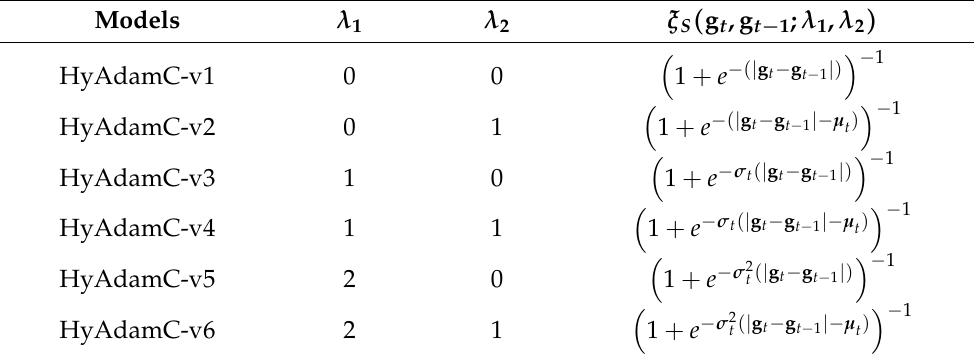
Table 2. The six models of HyAdamC created by setting λ 1 and λ 2 in Equation (17).